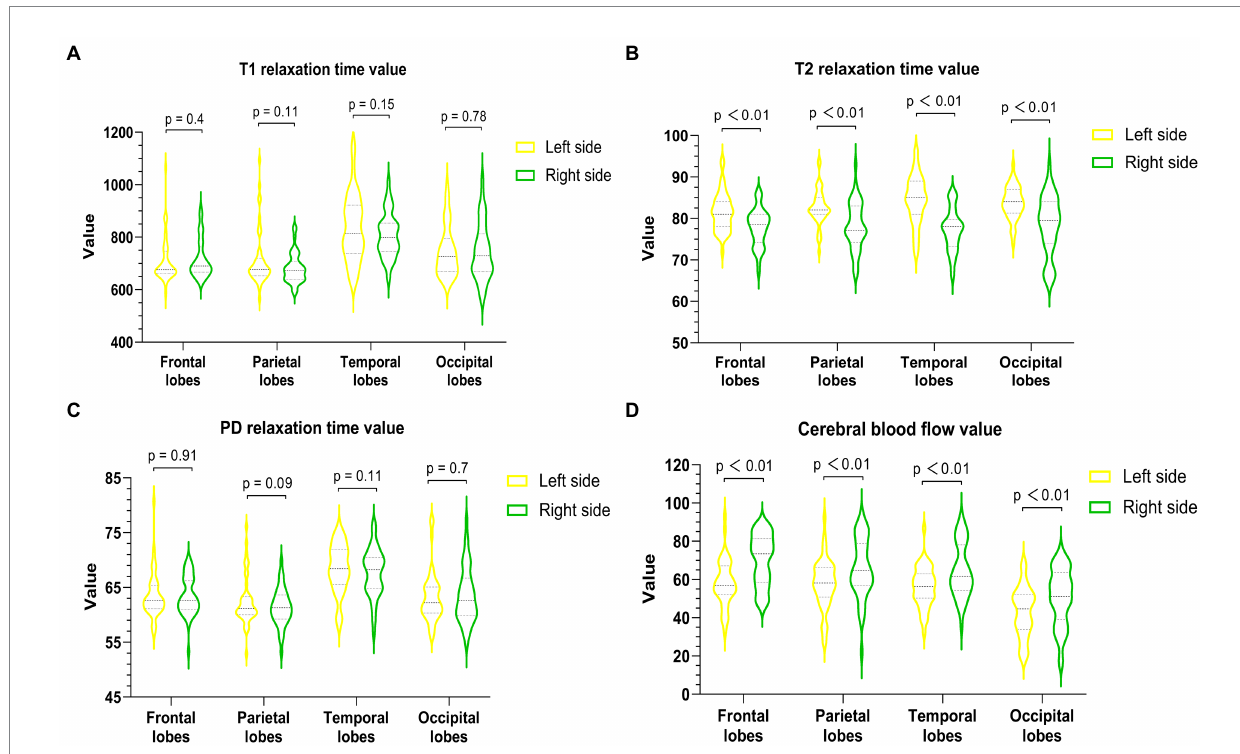
FIGURE 2 Quantitative measurement of T1 (A) , T2 (B) , PD (C) , and CBF (D) of the bilateral frontal lobe, parietal lobe, temporal lobe, and occipital lobe in PI patients. The T2 value of each right lobe was significantly lower than that of the corresponding left lobe ( p < 0.01), and the CBF value of each right lobe was markedly higher than that of the corresponding left lobe ( p < 0.01).